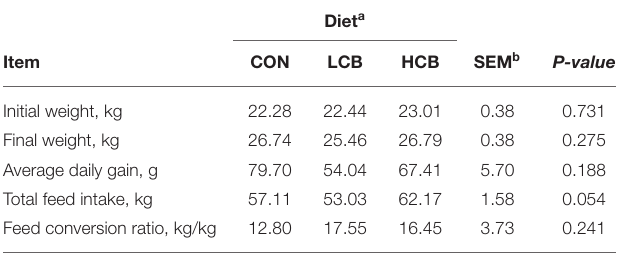
TABLE 3 | Effects of different doses of C. butyricum on apparent digestibility of fattening goats.